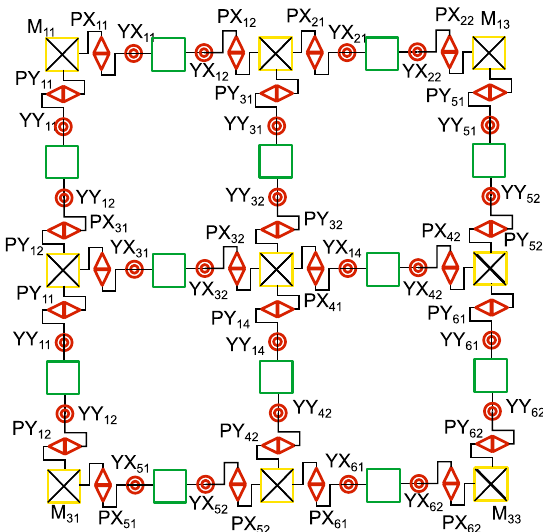
Fig. 11 Joint kinematic models of the simulation model of